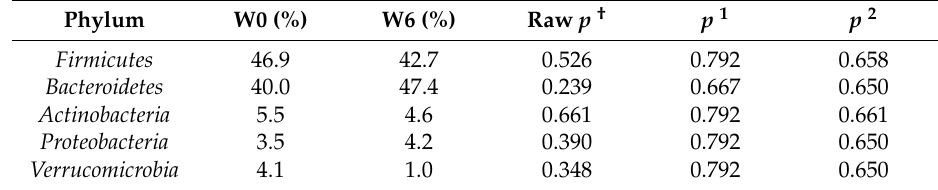
Table 3. Comparison of taxon abundance between the two time points (W0 and W6) at the level of phylum.